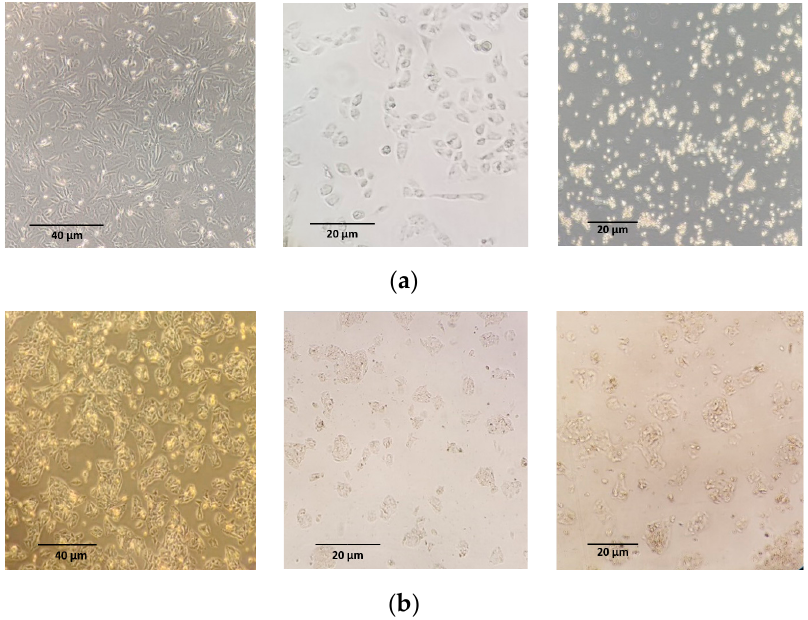
Figure 3. Microscopy images (via inverted microscope) of CHO-K1 cells ( a ) at 0 h (left), 6–9 h (cen- ter), and 24 h (right); HEP-G2 cells ( b ) at 0 h (left), 6–9 h (center), and 24 h (right) exposed to 10 mg/L CdSTe QDs.